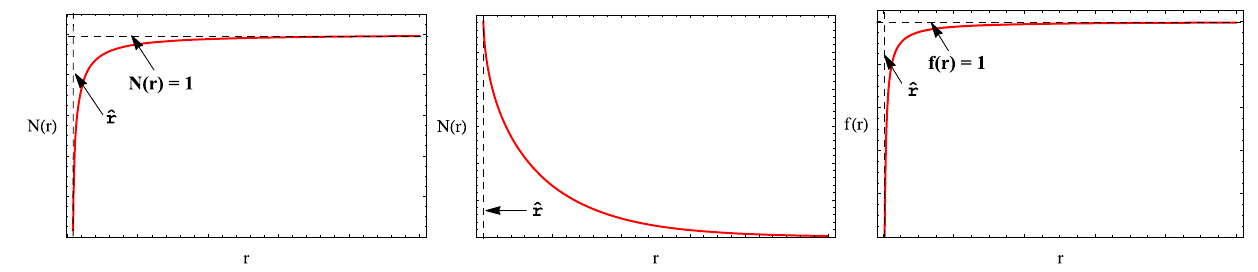
χ > ˆ χ (dashed black line). As it is appreciated, N tends to 0 making the metric (71) singular. Right panel: The function f against the radial coordinate r , for points χ < ˆ χ (dashed black line). As can be seen, this function shows an asymptotically flat behavior f → 1 when r → +∞